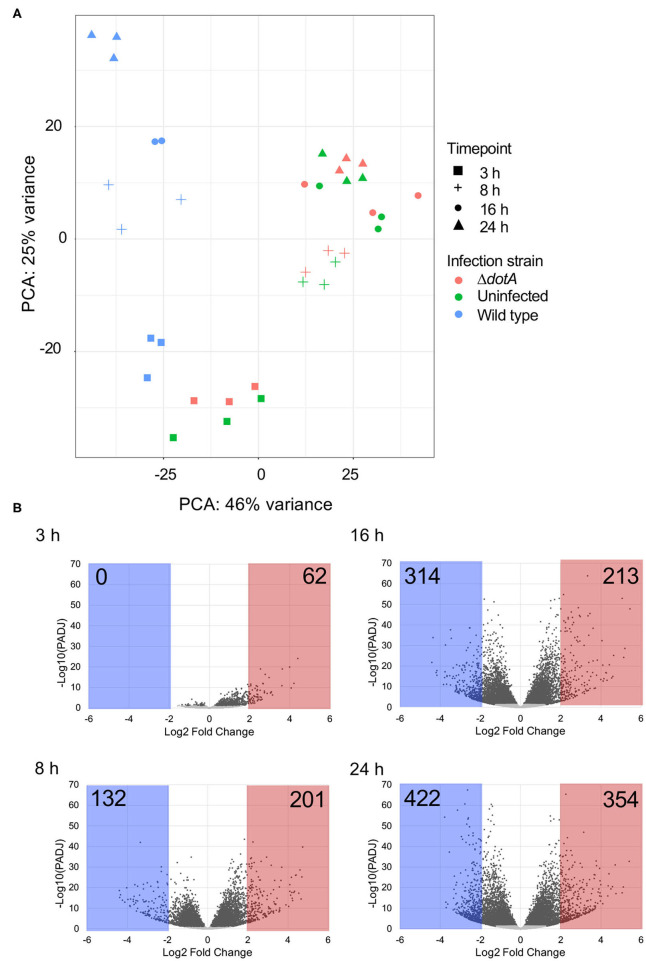
Differential gene expression of A. castellanii upon L. pneumophila infection. (A) Principal components analysis (PCA) showing the relatedness of sample transcriptomes across 2 principal component axes. Different strains are distinguished by color and time points by shape. (B) Global changes in A. castellanii gene expression after wild type Legionella infection relative to infection with ΔdotA L. pneumophila (WT vs. ΔdotA) at 3, 8, 16, and 24 h post infection. Volcano plots illustrate the distribution of change [log2(fold-change)] detected against significance, p-value adjusted for multiple testing using Benjamini–Hochberg to estimate the false discovery rate (PADJ). Points shaded gray represent genes with a PADJ > 0.05. These genes were omitted from subsequent analysis. Genes with a log2(fold-change) difference of > 2 are shaded red and < −2 are shaded blue.